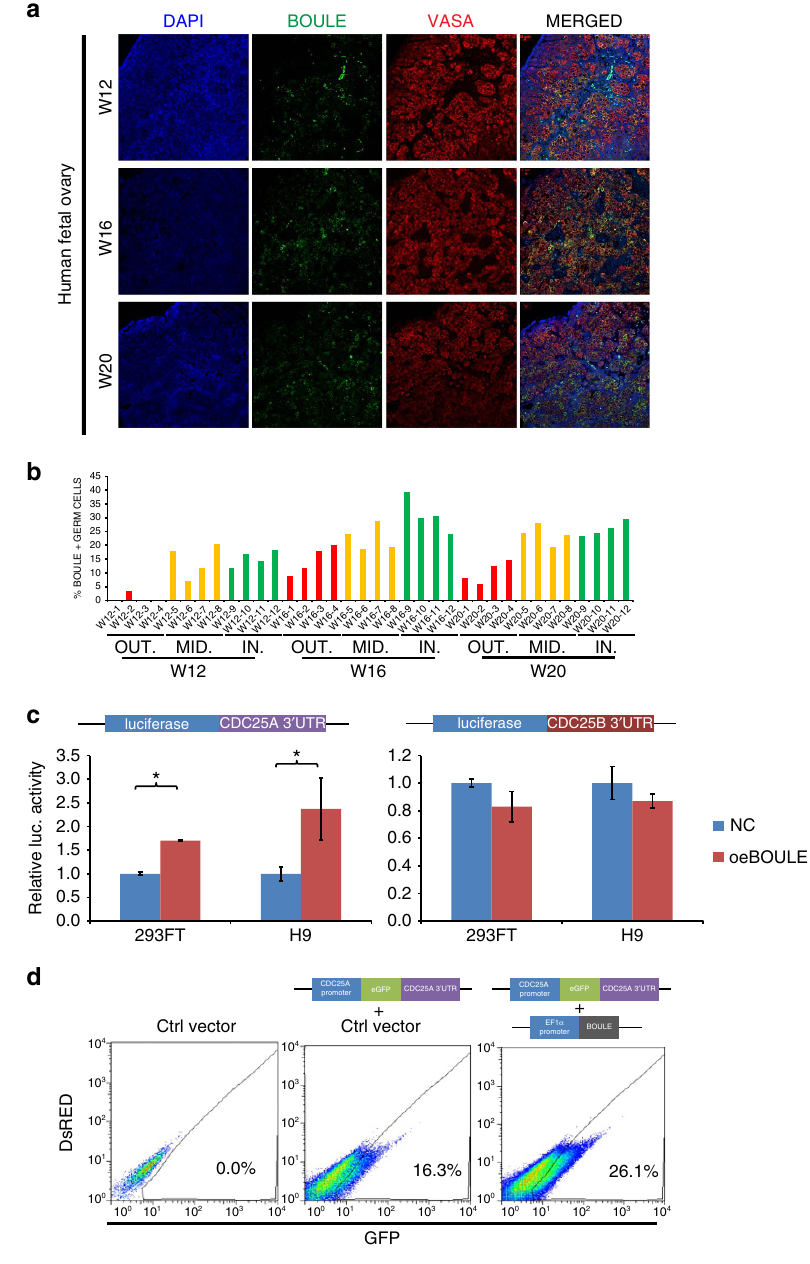
Figure 2 | BOULE upregulated 3 0 -UTR of CDC25A in hESCs. ( a ) Immunofluorescent staining of BOULE, VASA and DAPI (nuclei) in 12, 16 and 20W human fetal ovaries. Bar, 10 m m. ( b ) Distribution and location of BOULE-positive cells in cortex of human fetal ovaries. Percentages of BOULE-positive and VASA-positive cells in the 12, 16 and 20W human fetal ovaries were counted as described in Supplementary Fig. 3. Areas of ovarian cortex were divided into outer (OUT), middle (MID) and inner (IN) sections. n ¼ 4 different fields were counted in each section as shown in Supplementary Fig. 3. Each area contained 50–117 VASA-positive germ cells. ( c ) 3 0 -UTR Luciferase reporter assays of CDC25A or CDC25B in 293FTor H9 hESCs. Cells were transfected with empty vectors (NC) or BOULE-overexpressing vectors (oeBOULE). n ¼ 3 (biological replicates from B 25,000 cells), three independent experiments conducted, error bar is s.d., asterisks indicate statistical significance ( P o 0.05, Student’s t -test) between the two samples. ( d ) FACS analysis of CDC25A promoter-eGFP-3 0 -UTR reporter assays in hESCs. CDC25A reporter was integrated into hESCs followed by transduction of empty vector (Ctrl vector) or BOULE-overexpressing vector(oeBOULE), representative FACS results were shown, 50,000 cells of control cells without reporter (left plot) and 100,000 cells of cells carrying CDC25A 3 0 -UTR reporter (middle and right plots) were analysed. Three independent experiments were Therefore, we tested if BOULE regulates the luciferase activity promoter and 3 0 -UTR of CDC25A was fused to the through the 3 0 -UTR of CDC25A or CDC25B in human cells. Our enhanced green fluorescence protein (eGFP) gene and results indicate that overexpression of BOULE specifically transduced into hESCs, the percentage of eGFP-positive cells upregulated luciferase activity through the CDC25A 3 0 -UTR increased from 16.3 to 26.1% when BOULE was overexpressed in but not the CDC25B 3 0 -UTR, in both 293FT cells and H9 hESCs (Fig. 2d), showing CDC25A can be upregulated by BOULE hESCs (Fig. 2c). In addition, when a gene reporter carrying the in hESCs.